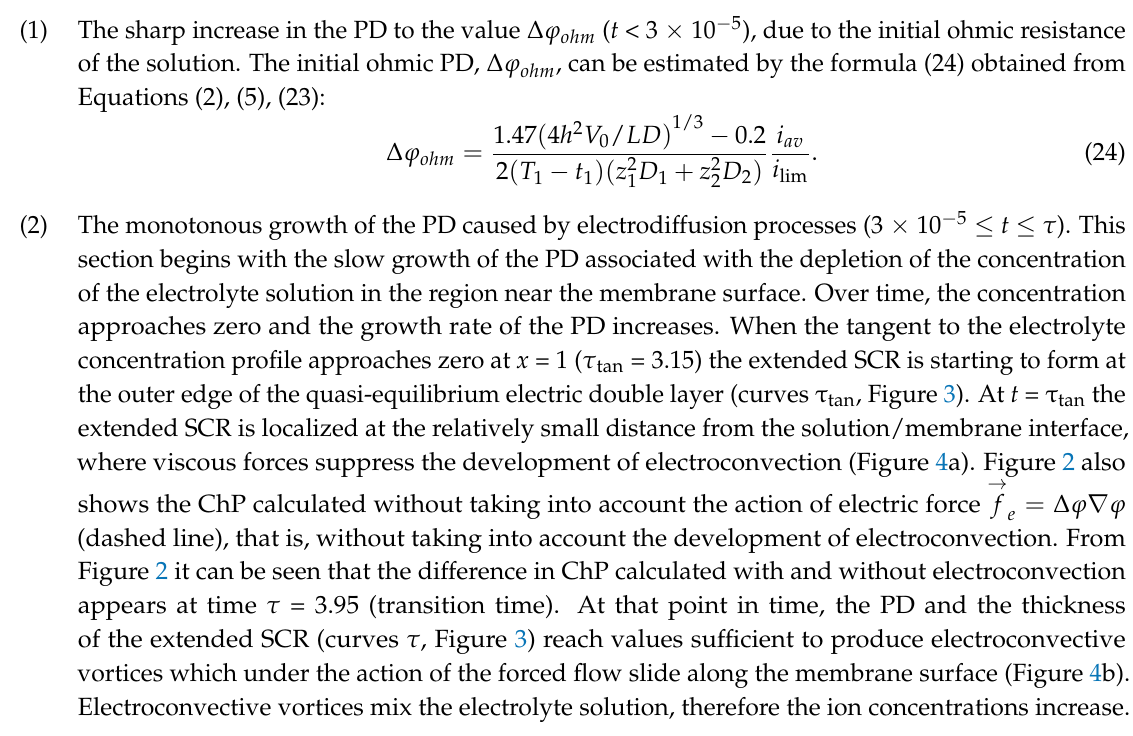
Figure 2. Chronopotentiograms (ChP) calculated with (solid red line) and without (dashed blue line) taking into account electroconvection at i av / i lim = 2. The dotted lines show the transition time τ = 3.95 and approximate time of establishing of the quasi-stationary state t 1 ≈ 17. The green line represents the dynamics of the averaged over the channel length thickness of the electroconvective mixing layer, d ec .